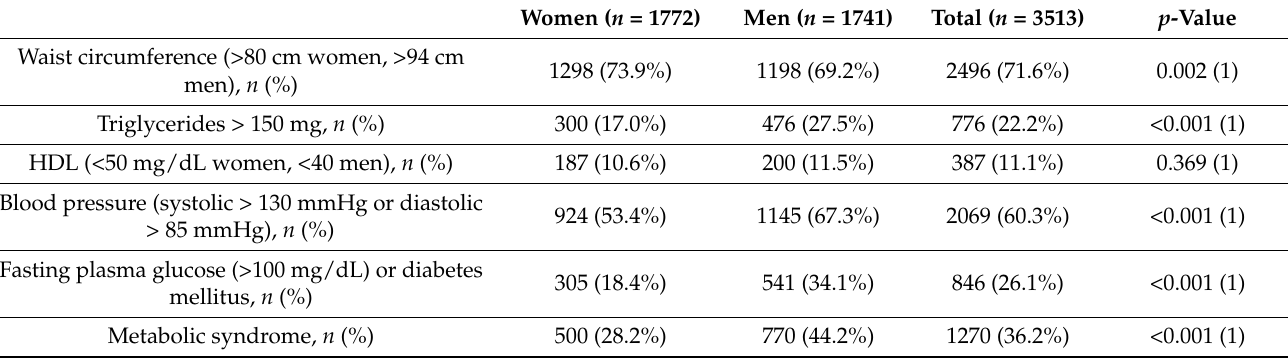
Table 4. Characteristics of the metabolic syndrome, according to the IDF index (2005). Women ( n =